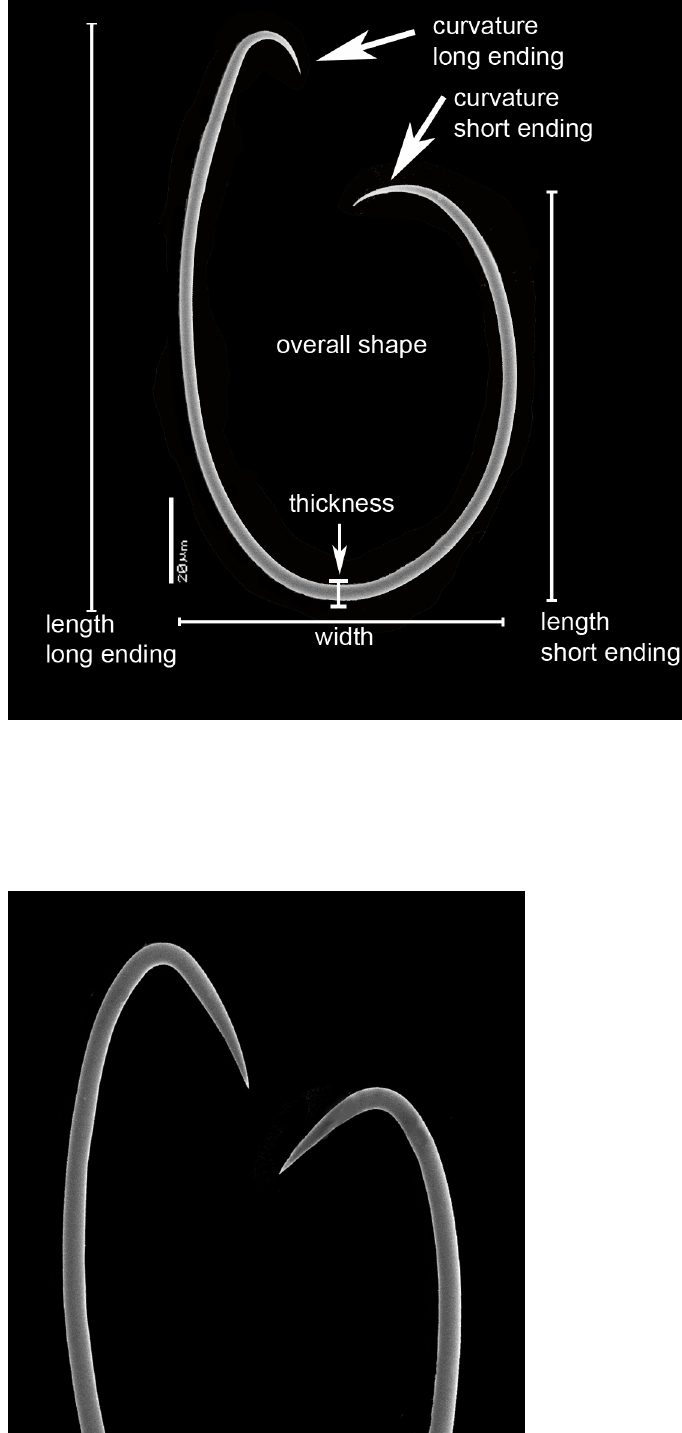
Fig. 2. ‘Flagellated’ sigma of Mycale ( Naviculina ) diversisigmata Van Soest, 1984, a sigma type superficially similar to a flagellosigma, but the morphology is considered non-homologous due to the lack of a strong asymmetry in the longer and